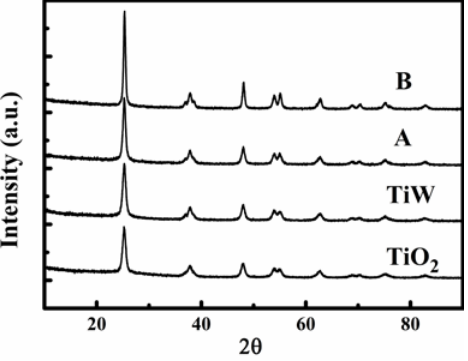
Figure 2. X-ray diffraction (XRD) profiles of catalysts A and B and major materials adopted in this study.